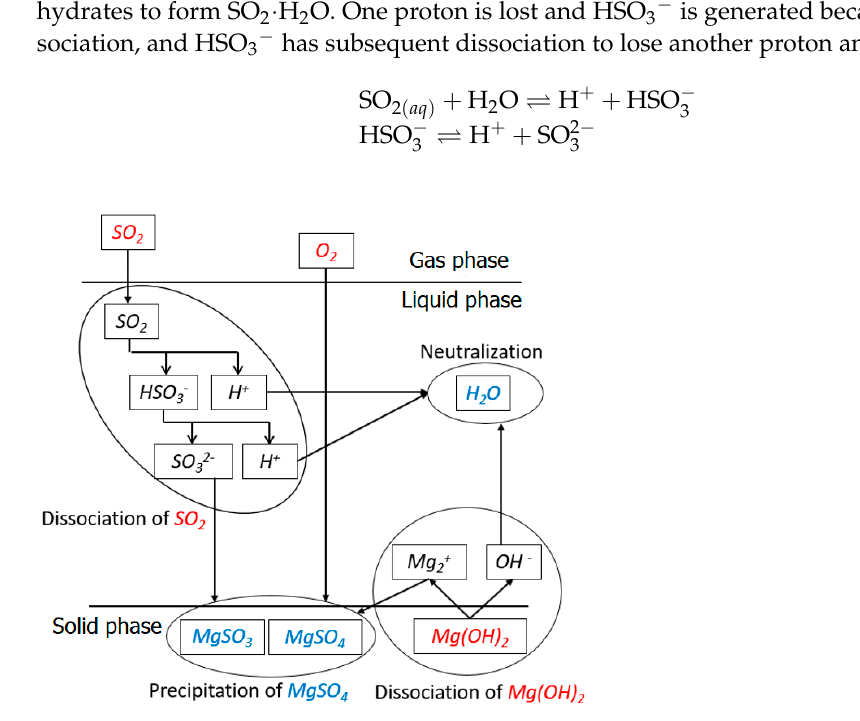
Figure 2. This schematic illustrates the chemical reactions during the desulfurization process. The subscript “( aq )” in Equation (6) denotes the aqueous phase. The Mg(OH) 2 solution is a strong electrolyte, which can dissociate completely to release magnesium ions (Mg 2+ ) and OH − ions. The neutralization takes place between OH − ions from Mg(OH) 2 and H + ion from Equation (6):